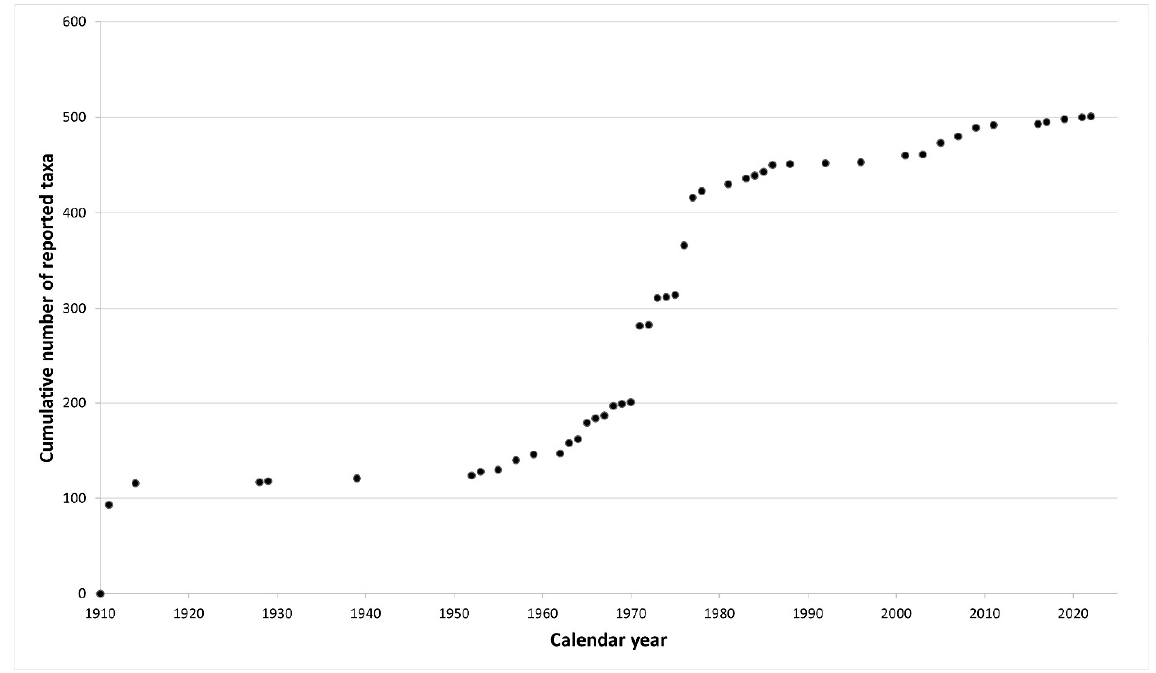
Figure 2. Cumulative number of reported taxa of macrophytes over time, in the N-PNPC, since the early 20th century.